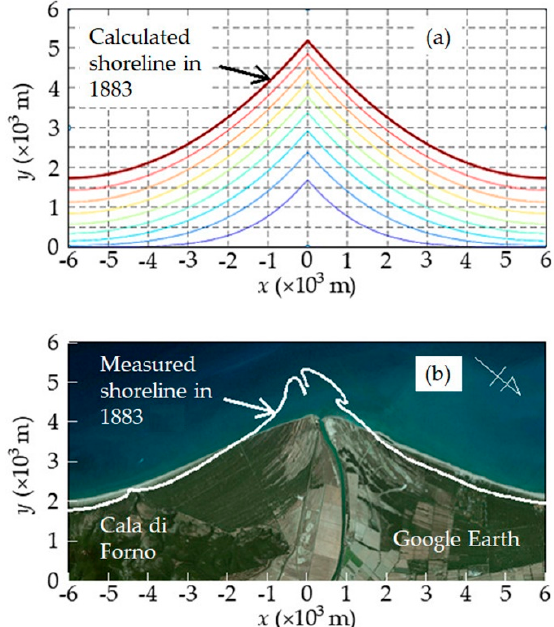
Figure 14. Calculated and measured shorelines in 1883 of the Ombrone River delta. The time interval for calculated shorelines in ( a , b ) is 100 years.